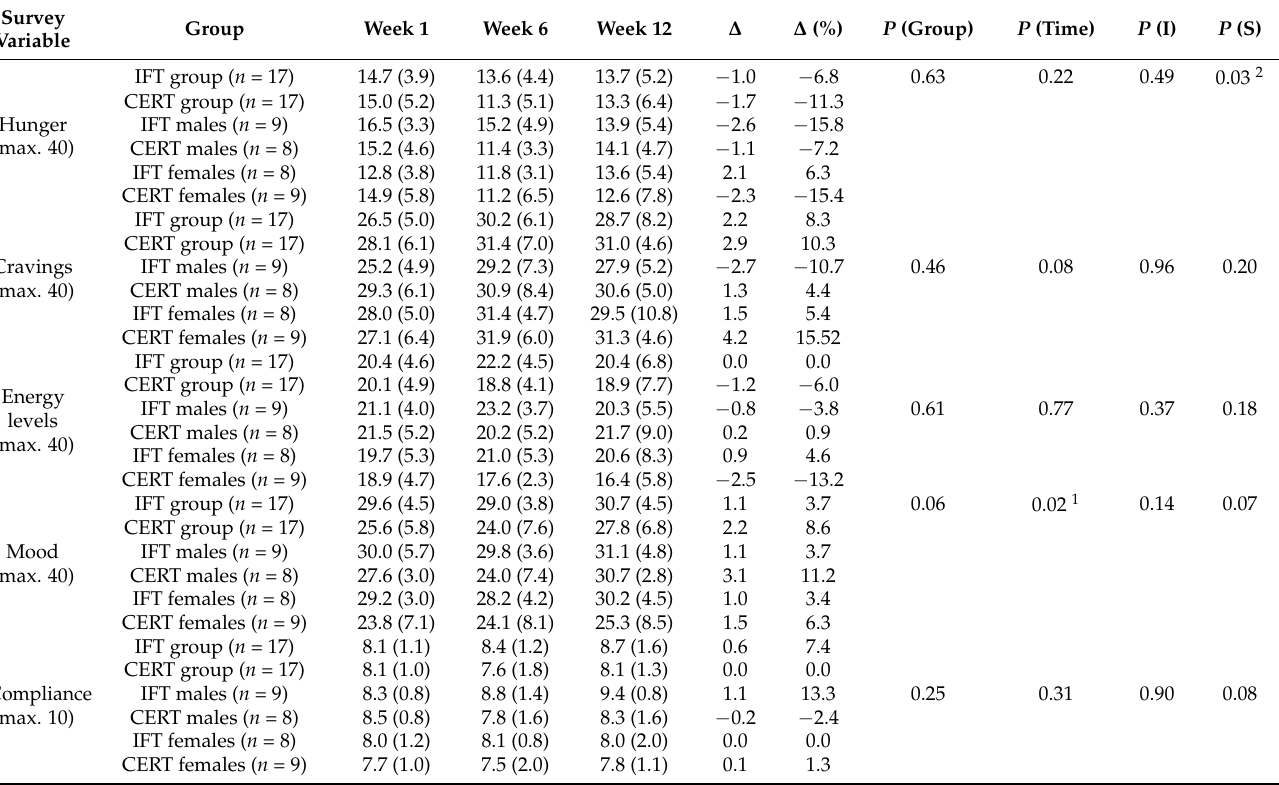
Table 5. The effects of 12 weeks of IFT and CERT with resistance exercise on mean ratings of hunger, cravings, energy levels, mood and